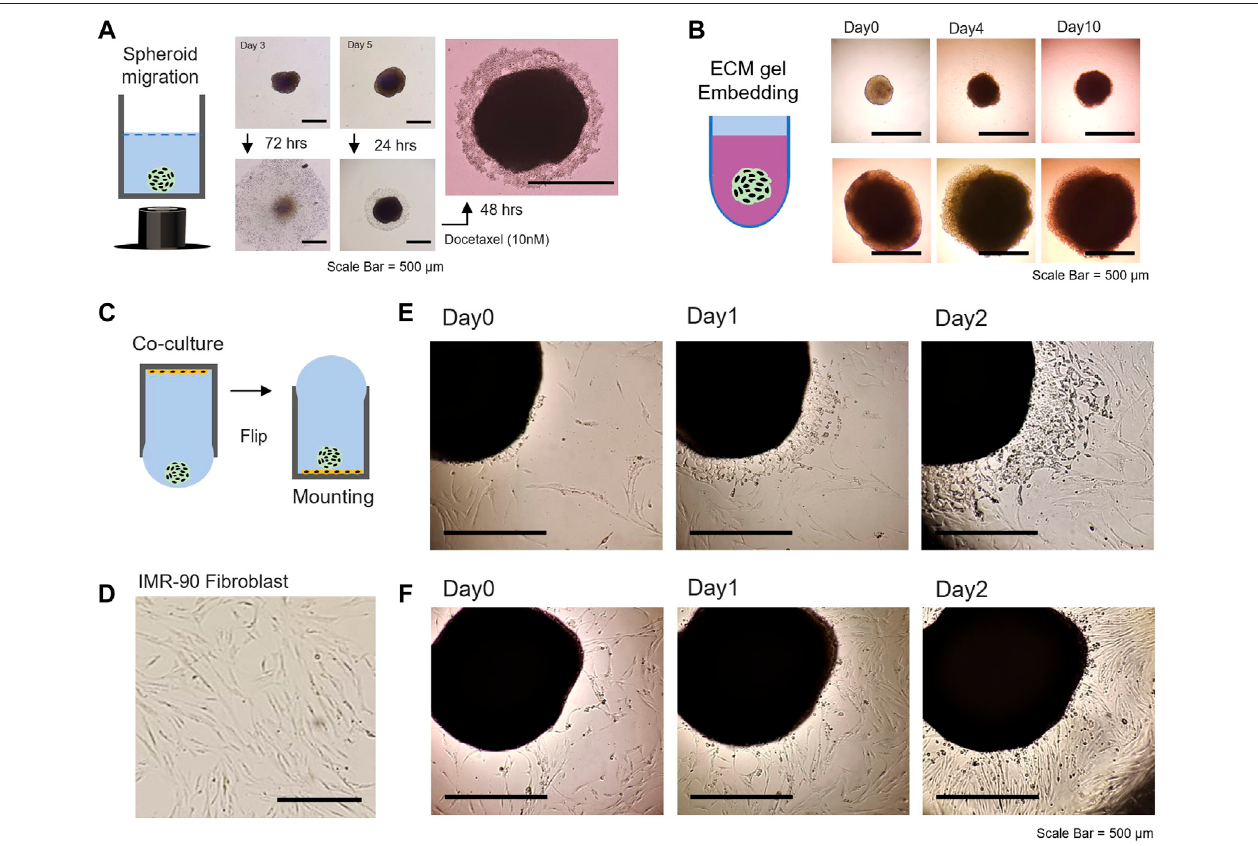
FIGURE 4 | Evaluation of 3D spheroids; cellular motility, matrix embedment, co-culture, and dissemination. (A) Tumor spheroid migration on the 2D bottom of 96- well plate after fl ipping [middle panel: for 72 h, right panel: drug treatment of docetaxel (10 nM) after 24 and 48 h]. (B) Tumor spheroid embedding assay in the environment of ECM-like hydrogel. 3D HTC 116 spheroids with different sizes (cultivated for 5 days, upper panel and 15 days, lower panel) were embedded in Matrigel andmonitoredforupto10 days. (C) SchematicillustrationofaWPFapproachforco-culturestudies. (D) ImageofthemorphologyofIMR-90 fi broblastsadheredto the bottom of a 96-well plate. 3D spheroid dissemination on the 2D substrate with IMR-90 lung fi broblast. (E) Microscopic image of 20% con fl uency and (F) 50% con fl uency of IMR-90 fi broblasts with 3D HCT116 spheroid (prepared for 10 days). The scale bar is 500